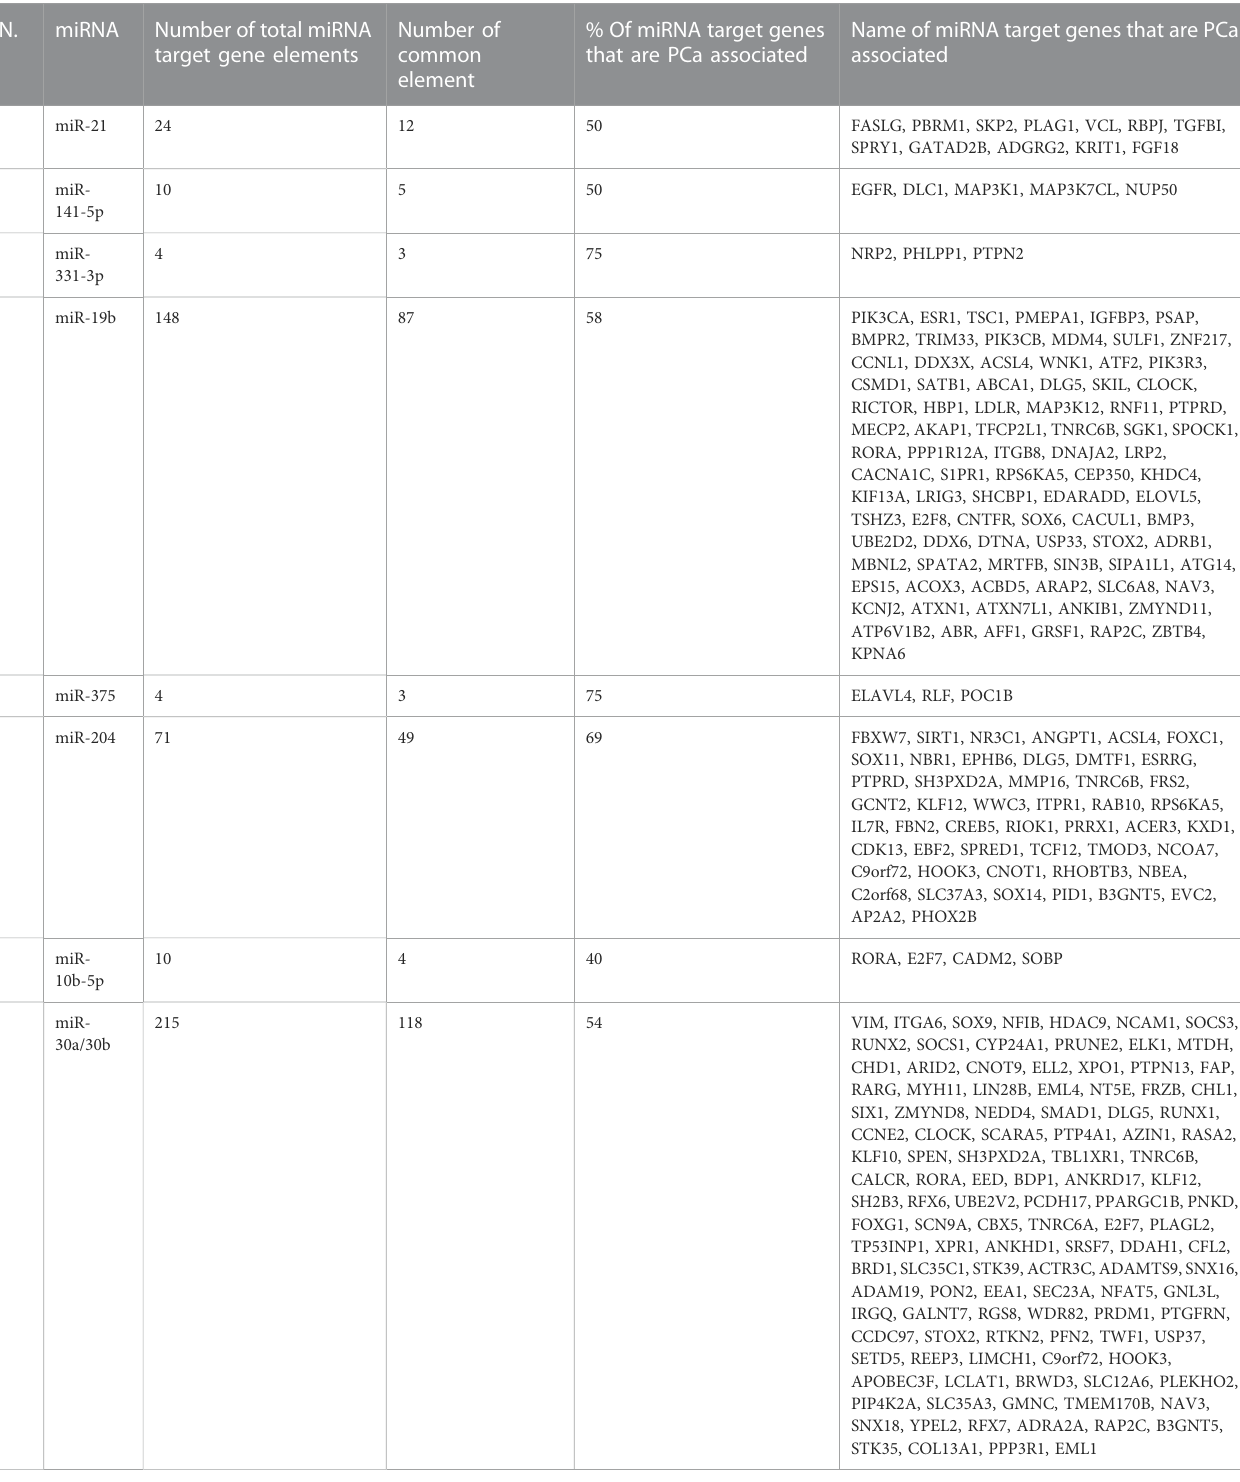
TABLE4MostfrequentlyreporteddysregulatedmiRNAsinurinaryexosomesofprostatecancerpatients.ThelistoftargetedgenesforeachmiRNAwasretrievedusing miRDB and TargetScan. Only the target genes with a score of > 95 were considered in the next step. Another list of prostate-associated genes was retrieved using the keyword “ Prostatecancer ” ingenecards,providingtheoutputofaround12,400genes.Elementsonbothlistswerethencomparedtoretrievecommonelementsusing Venny2.1 software and the output result of the common element was collected in the form of a Venn Diagram and list.